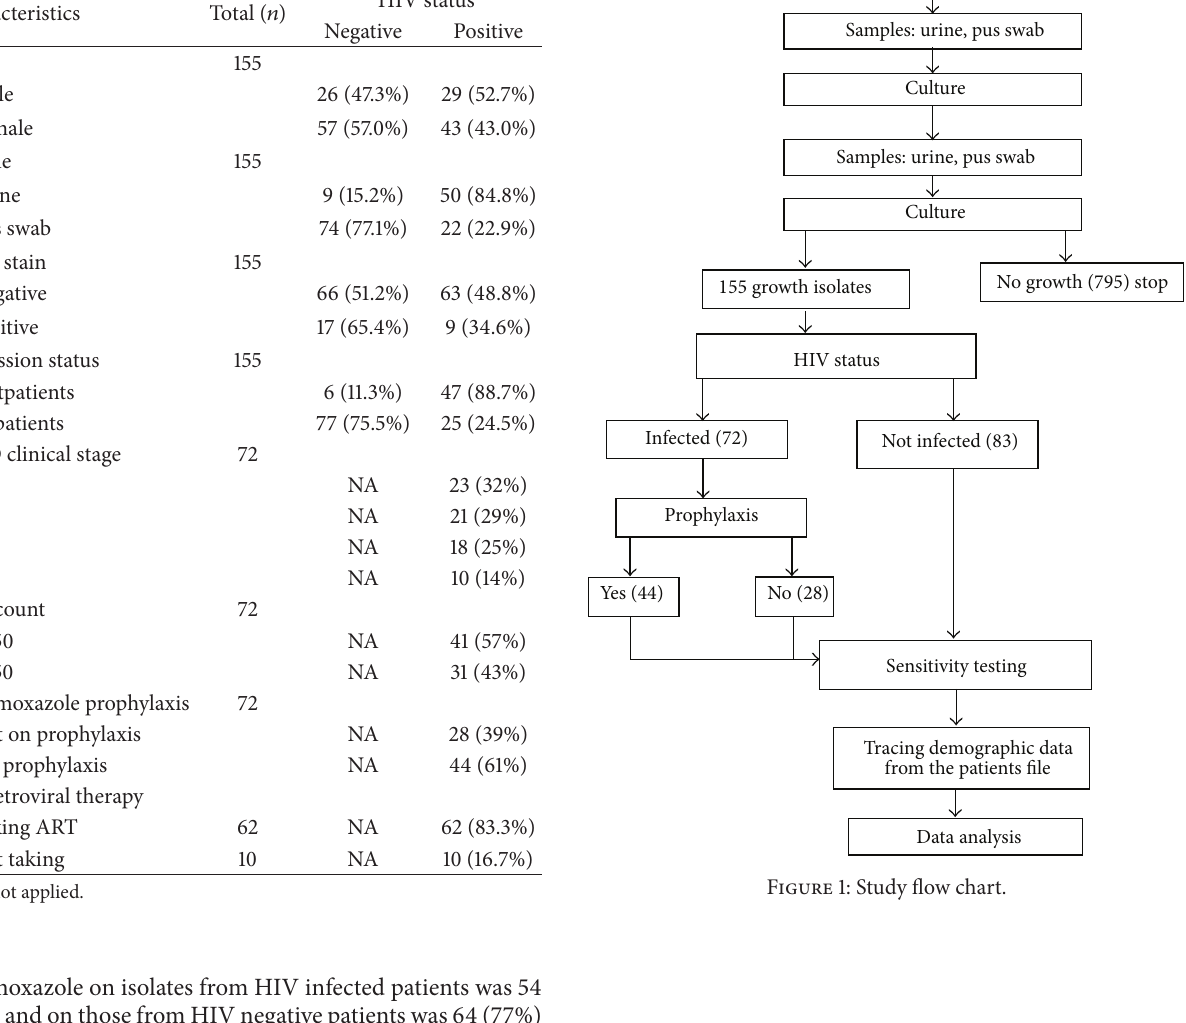
Table 1: Background characteristics of 155 patients as categorized by HIV status.